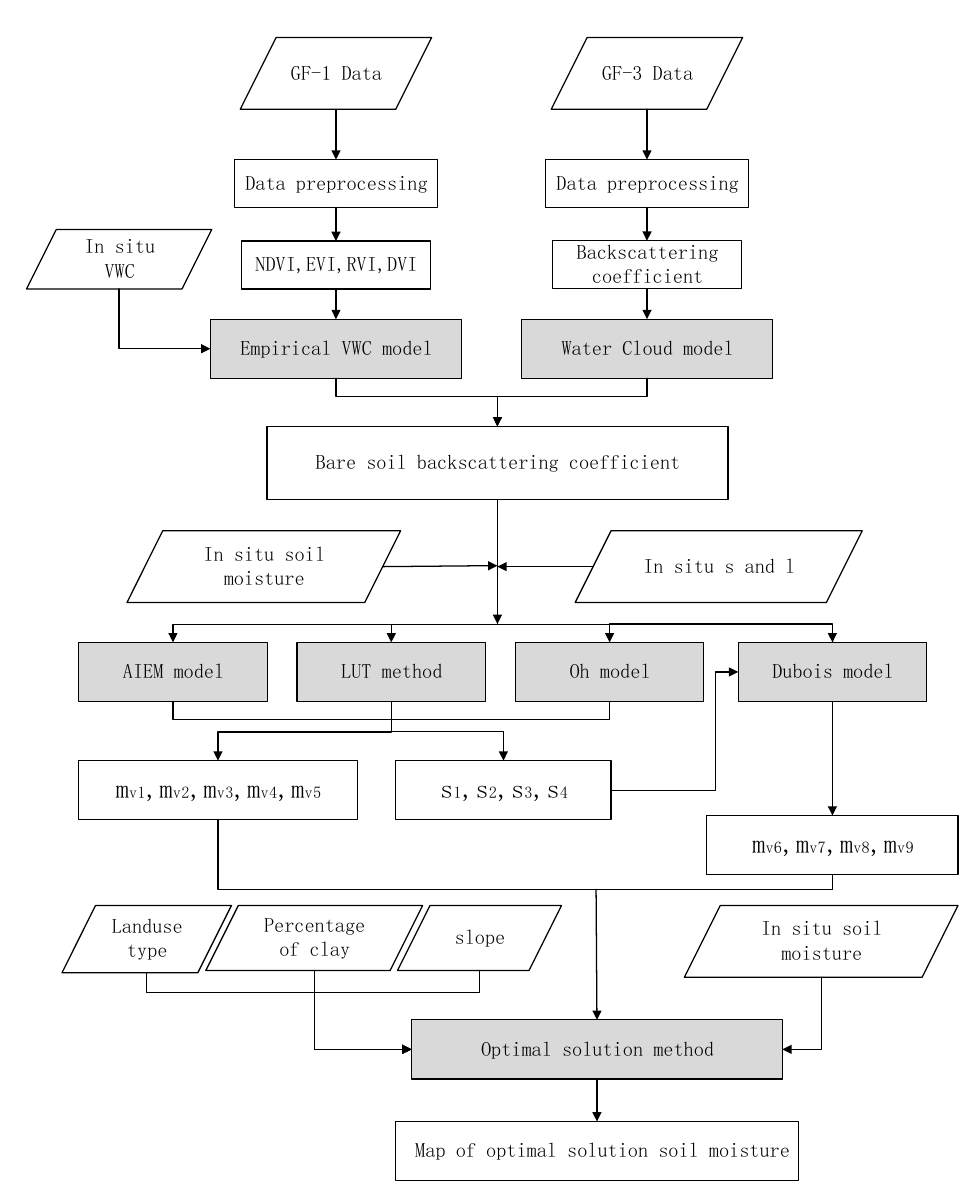
Figure 4. Flowchart of the proposed soil moisture mapping. VWC, vegetation water content; m vn , soil moisture content obtained by four commonly used models; s and l: the root-mean-square (RMS) height and correlation length.